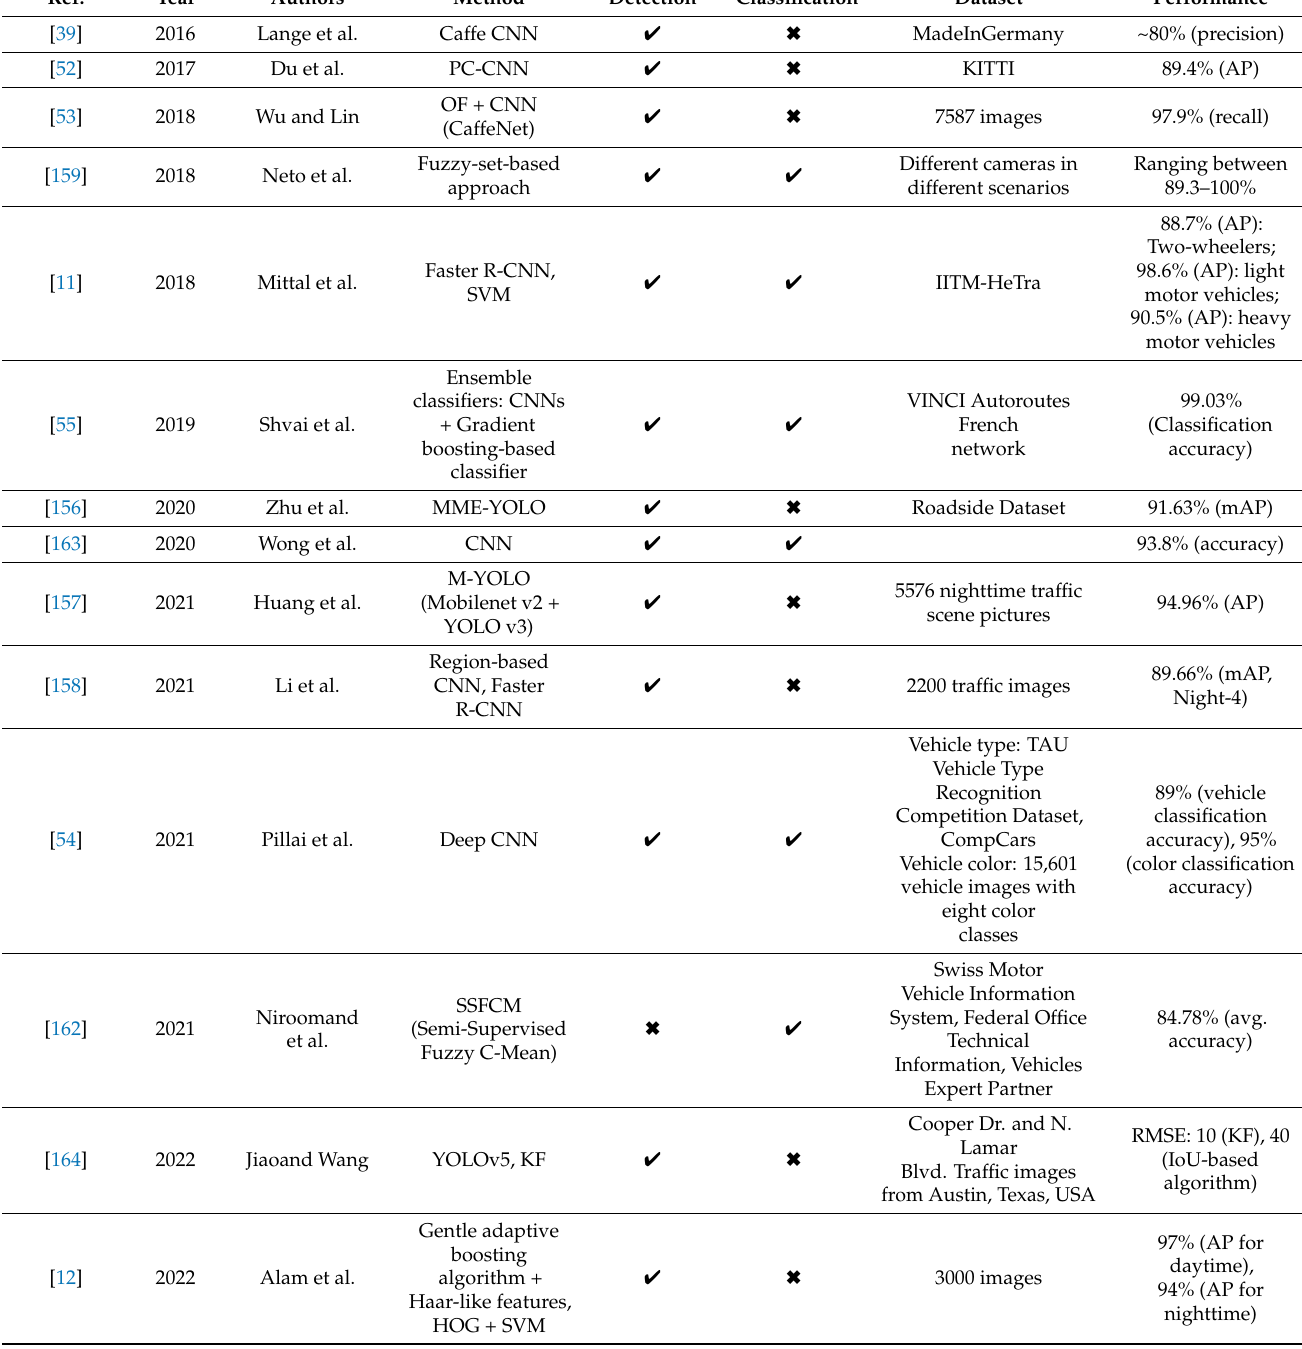
Table 5. Vehicle Detection and Classification Studies with CV Methods.